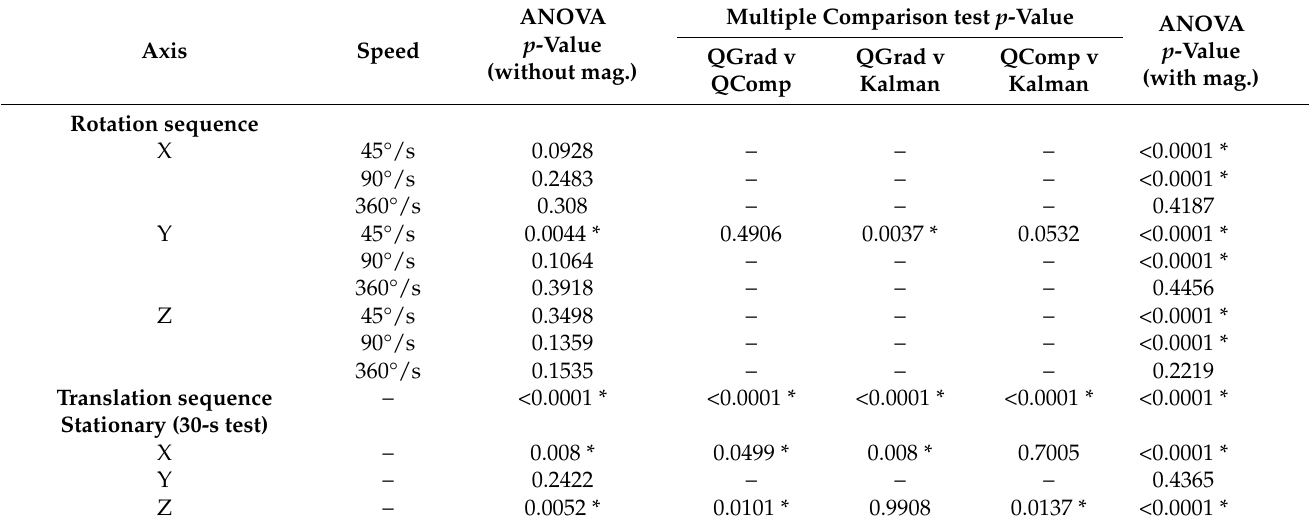
Table 4. Results of ANOVA and multiple comparison tests for the difference in mean error for QComp, QGrad, and Kalman filters. Axis refers to the IMU axis of rotation for the rotation sequence and the IMU axis aligned with gravity for the stationary trial. Significant differences ( p < 0.05) indicated with an asterisk (*). Multiple comparison test results are not included for the Kalman filter with the magnetometer enabled because it is the instances of comparable performance that are of interest in this case.